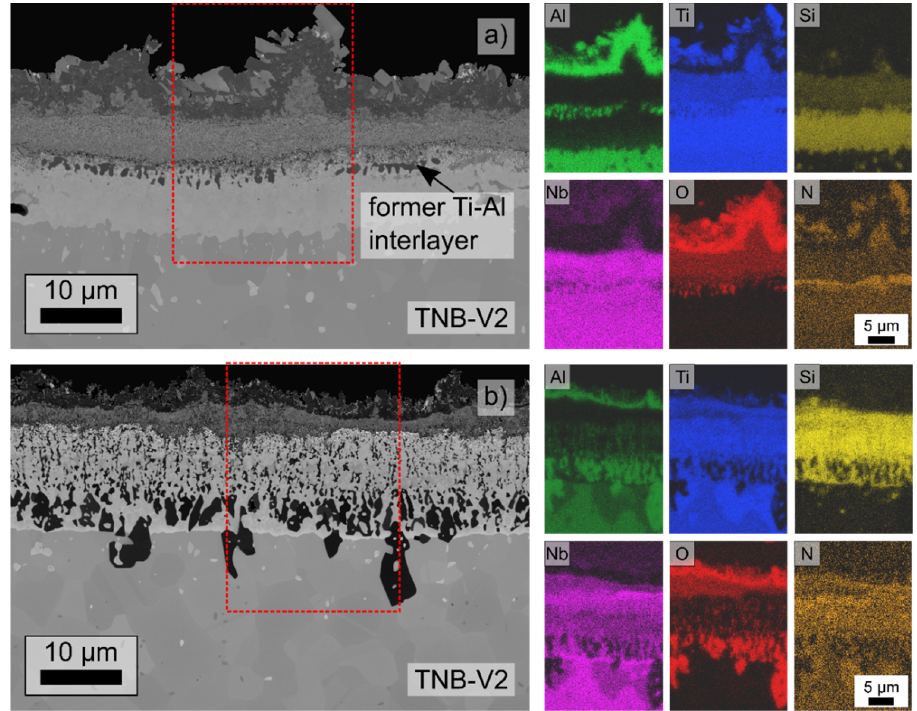
Figure 14. SEM cross sections of the Al-58Si ( a ) and Al-81Si ( b ) coatings (all in at.%) after 5000 cycles of oxidation at 900 °C with elemental mappings of the red marked area. of oxidation at 900 ◦ C with elemental mappings of the red marked